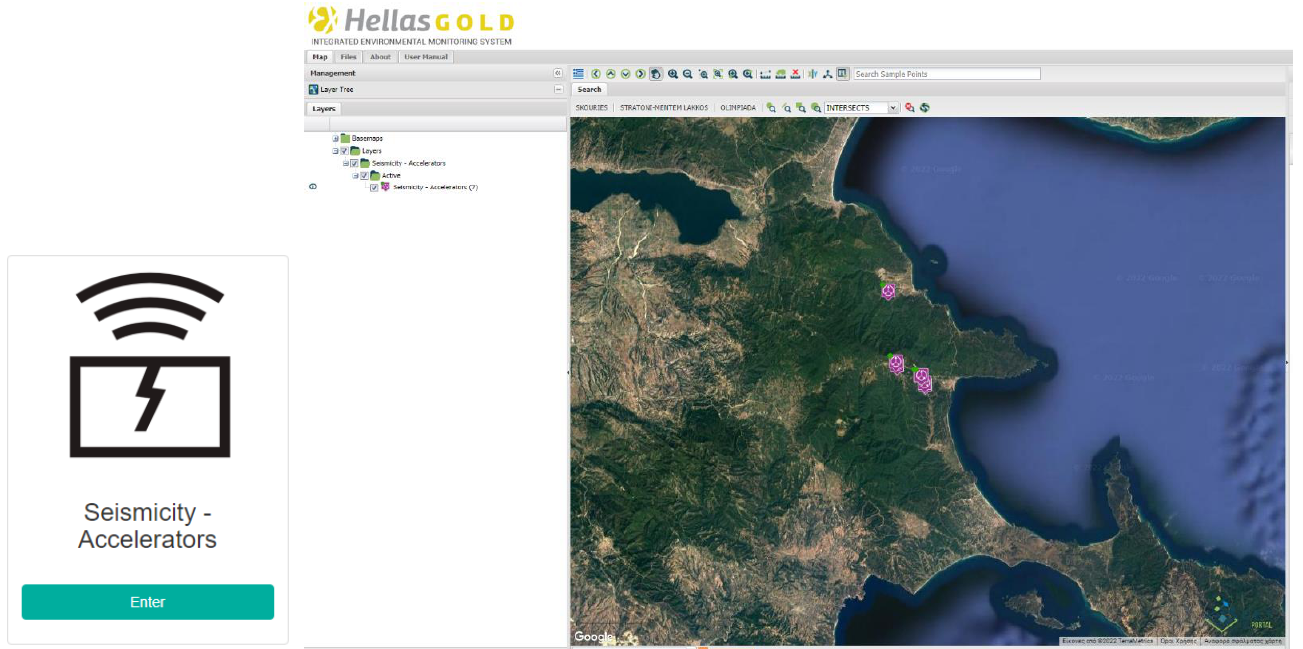
Figure 11. Seismicity database main screen.